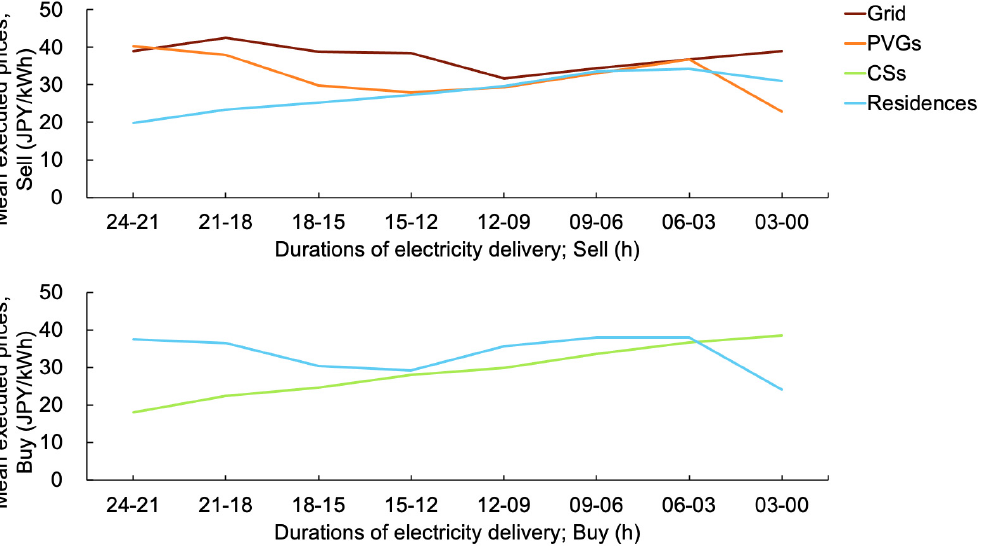
Figure 9. Mean executed prices for each duration of electricity delivery in the target period.